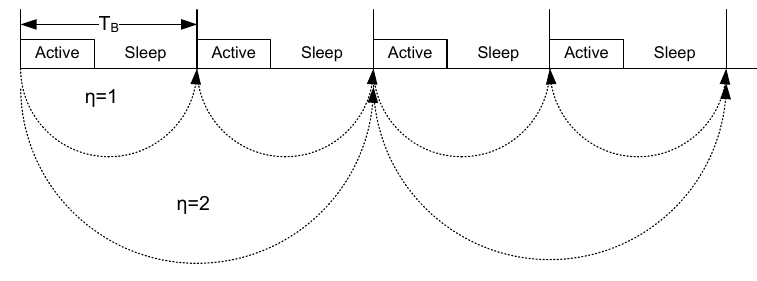
Figure 5. Communication Period.